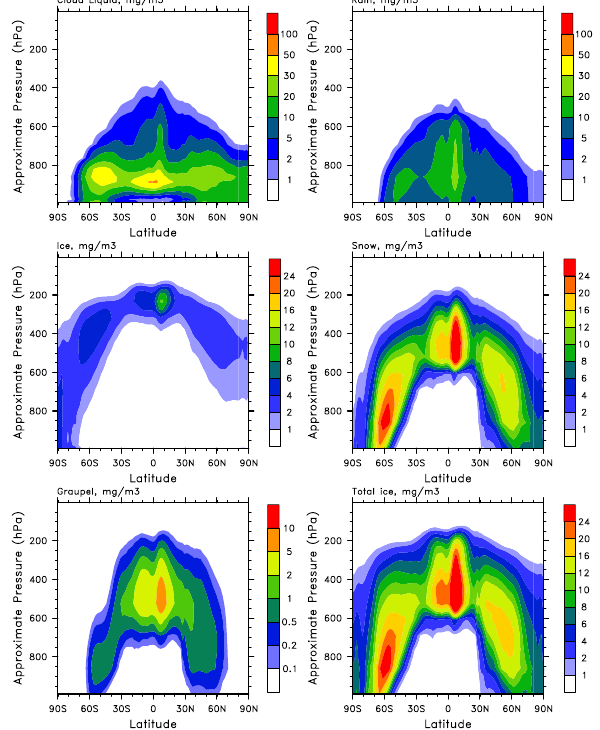
Figure 01 Fig. 1. Annual-averaged zonal-mean grid-mean mass concentra- tions (mgm − 3 ) of cloud liquid water, rain water, ice water, snow water, graupel water, and total ice water (ice+snow+graupel) in PD in the MMF. The host GCM model (CAM5) uses a hybrid verti- cal coordinate and the pressure at the k th model level is given by p(k) = A(k)p 0 + B(k)p s , where p s is surface pressure, p 0 is a specified constant pressure (1000 hPa), and A and B are coeffi- cients. Data are plotted as a function of this hybrid vertical coor- dinate times 1000, and labelled “Approximate